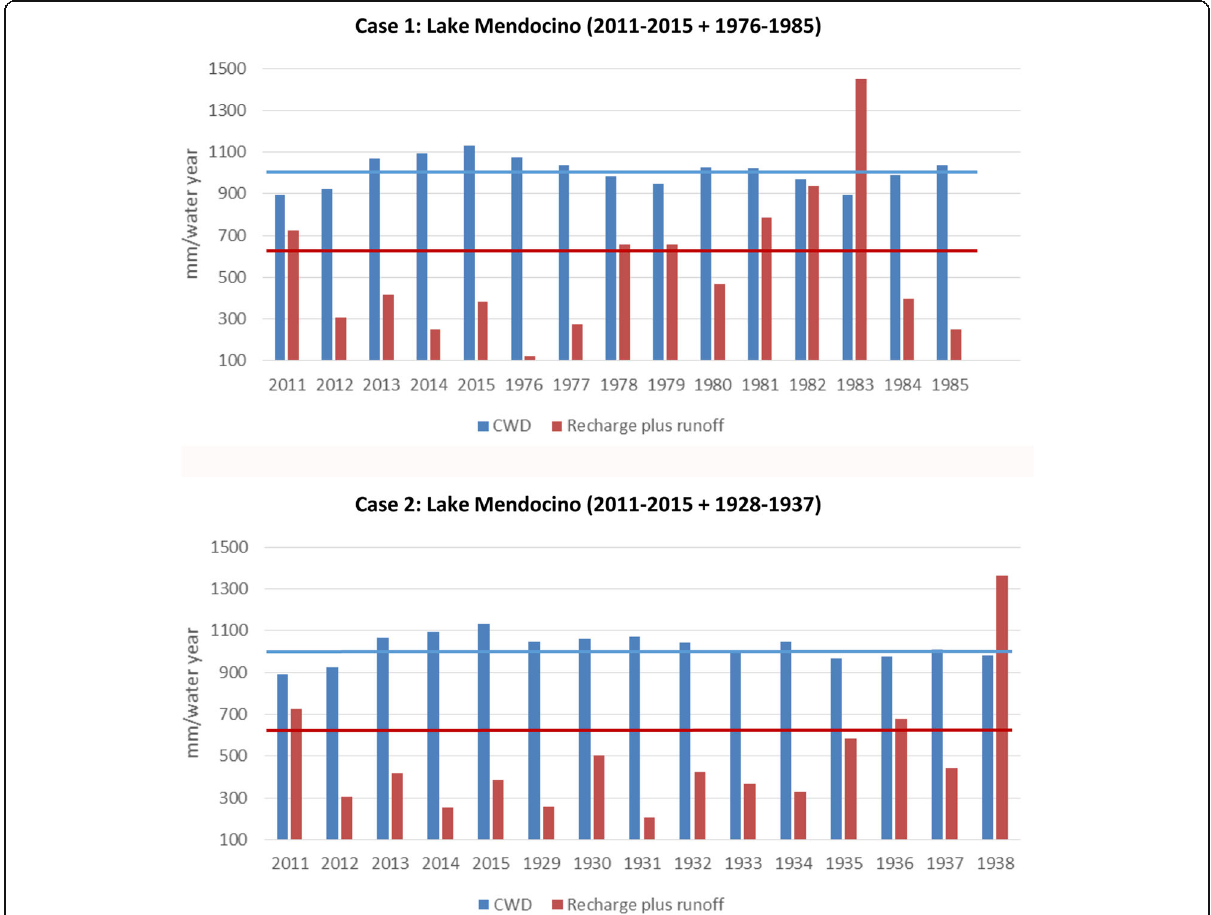
Fig. 8 Climatic water deficit and water supply (defined as recharge plus runoff) for the Lake Mendocino basin for each extreme drought scenario sequence of years. Horizontal lines indicate long-term average for each